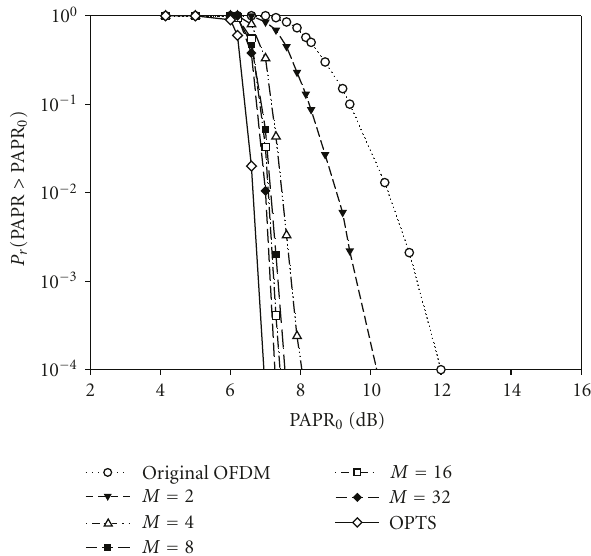
Figure 4: CCDF of the PAPR with the PTS technique searched by PSO technique when N = 256, M = 2, 4, 8, 16, and 32.